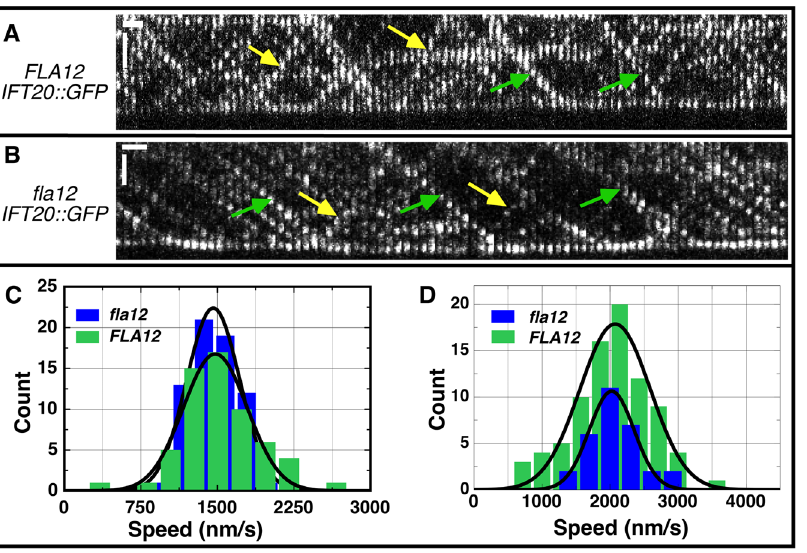
Fig 5. IFT velocities are not changed in the fla12 mutant. Kymographs of IFT20::GFP in (A) FLA12 and (B) fla12 strains. Green and yellow arrows denote representative anterograde and retrograde tracks, respectively. Vertical scale bar, 2 μ m; horizontal scale bar, 1 sec. (C) The anterograde IFT velocities were 1478 ± 41 nm/s (mean ± SEM) for FLA12 cells (green, n = 60) and 1460 ± 32 nm/s for fla12 cells (blue, n = 67). (D) The retrograde IFT velocities were 2074 ± 56 nm/s for FLA12 cells (green, n = 84) and 2023 ± 60 nm/s for fla12 cells (blue, n =